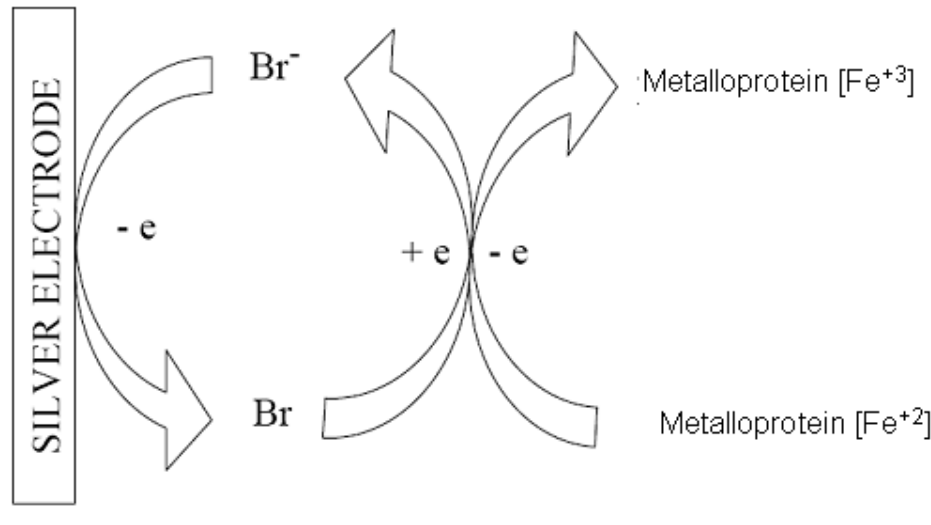
Figure 8. Schematic diagram of electron exchange process between bromide-modified silver electrode and metalloproteins in the solution.